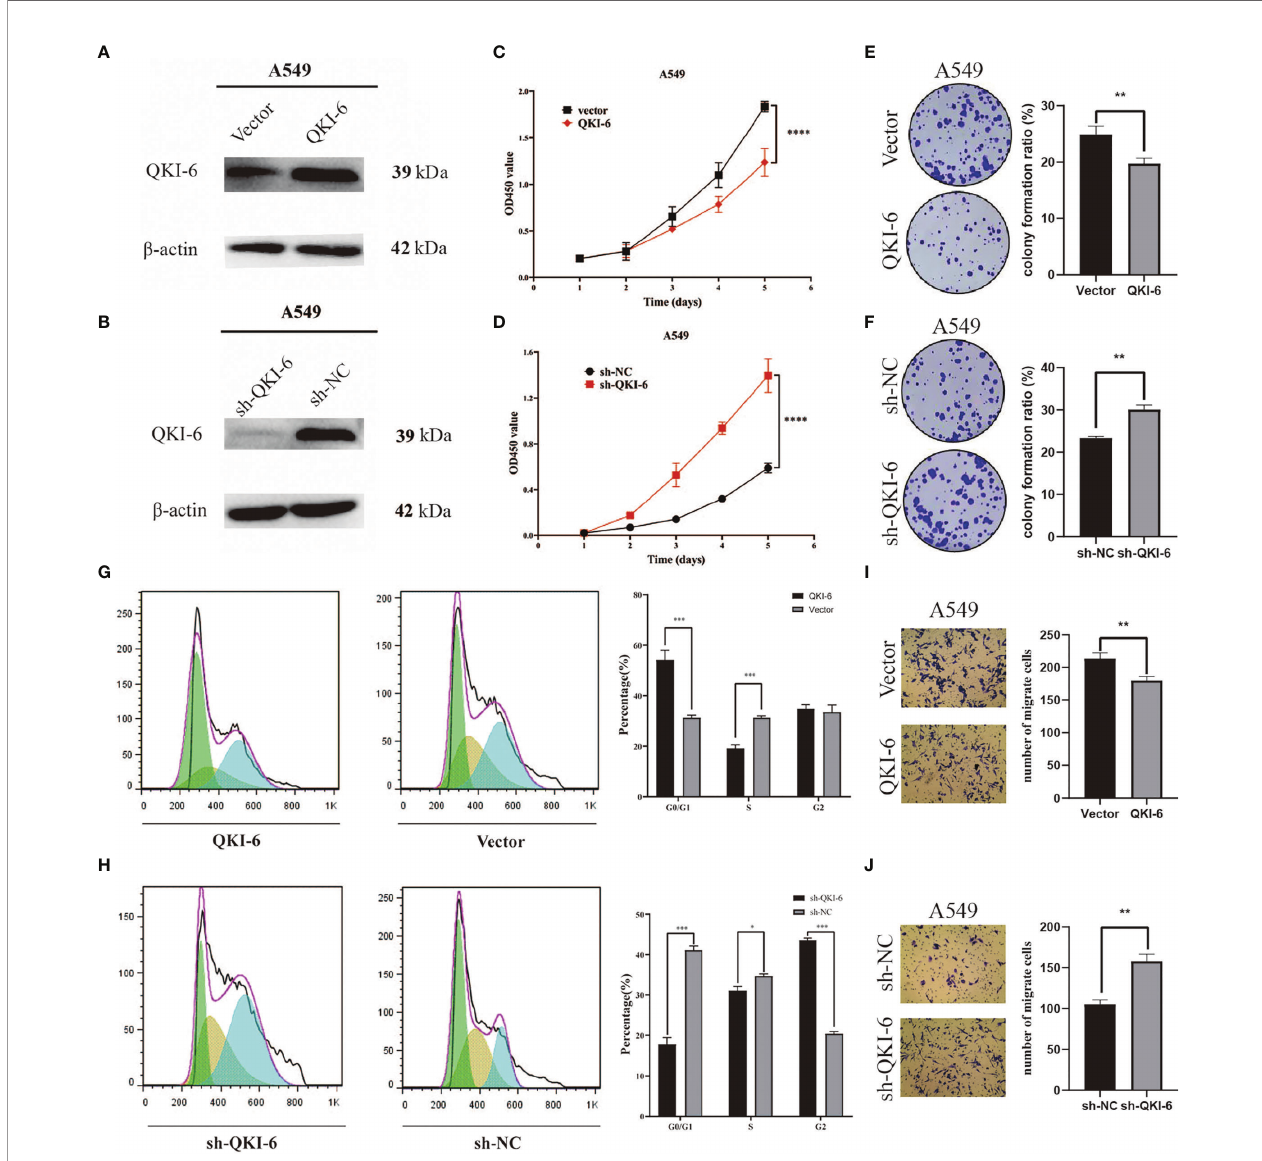
FIGURE 3 | QKI-6 overexpression reduced proliferation and migration in NSCLC cells. (A, B) QKI-6 levels in QKI-6 overexpression A549 cell lines, QKI-6 shRNA interfering A549 cell lines, and normal A549 cell lines. (C, D) Growth curves of QKI-6 overexpression A549 cells, vector (C) , QKI-6 knockdown A549 cells, and sh- NC A549 cells (D) . Cell viabilities detected by the CCK-8 assay shown as optical density (OD) values. (E, F) Colony formation assay results showing the impact of QKI-6 knockdown and QKI-6 overexpression in A549 cells. (G, H) Flow cytometric study of the cell cycle. More cells overexpressing QKI-6 were arrested in the G0/1 phase, and more cells with QKI-6 knockdown entered into the S and G2 phases of the cell cycle. (I, J) Transwell migration assays using QKI-6 knockdown A549 cells and QKI-6 overexpression A549 cells. All assays were performed independently at least three times and data were presented as the mean ± SD; one-way ANOVA analysis of three independent experiments. * P < 0.05, ** P < 0.01, *** P < 0.0001, **** P <